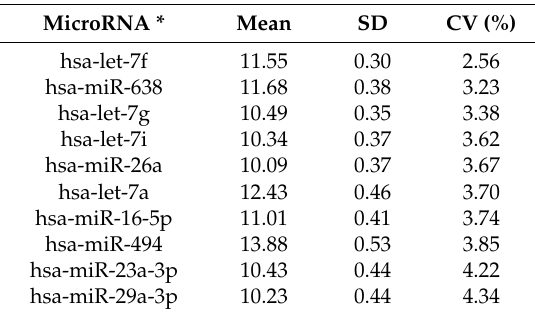
Table 2. MicroRNA expressions of validation